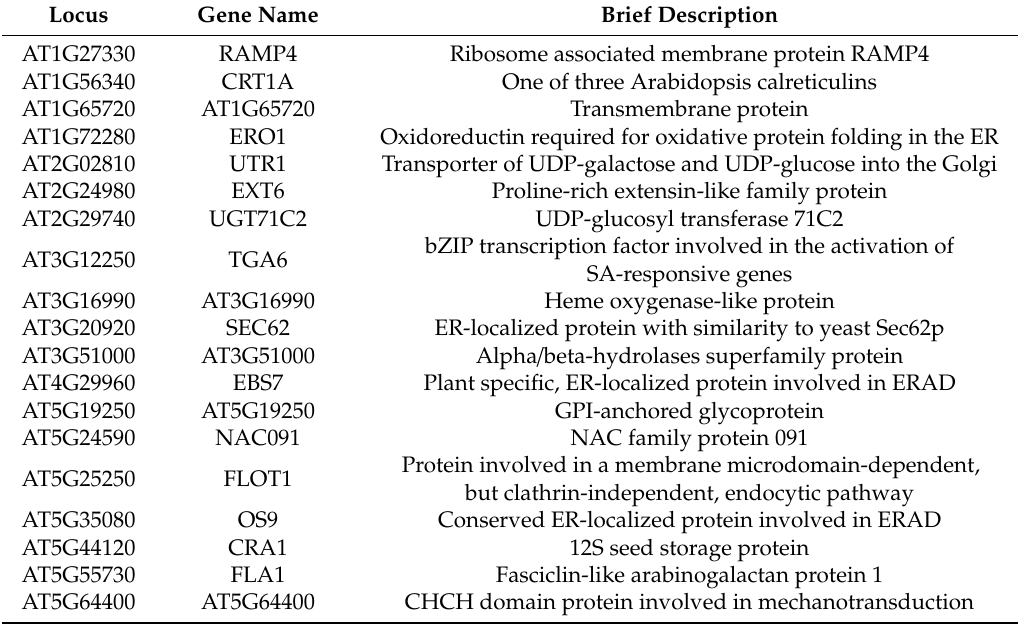
Table 2. Lists of proteins that specifically upregulated by ER stress in Col relative to L er .